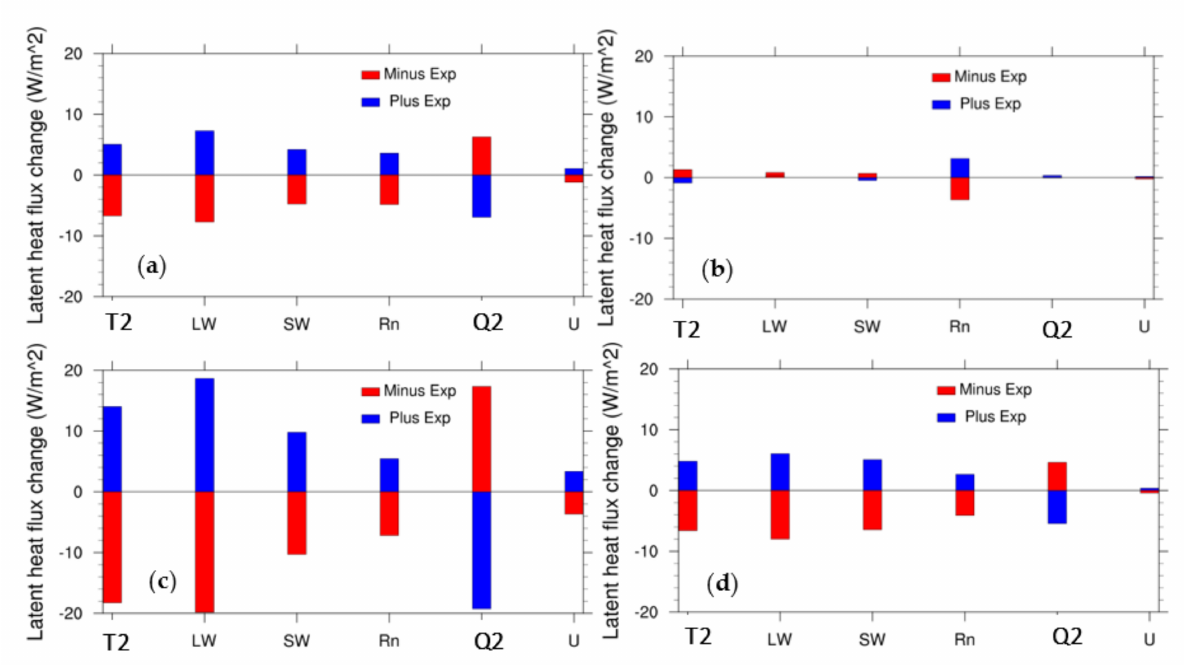
Figure 11. Latent heat flux change (W/m 2 ) averaged over the Indian region from all the sensitive experiments. ( a ) Annual, ( b ) MAM, ( c ) JJA, and ( d )